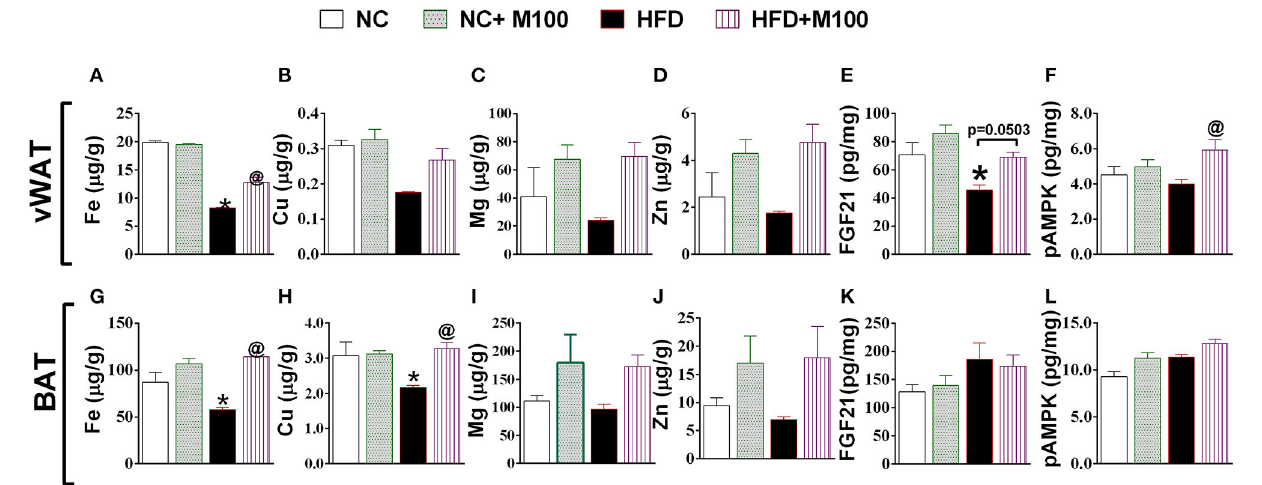
FIGURE 7 | Effect of chronic oral administration of menthol on (A–D) metal concentration (Fe, Cu, Mg, Zn) in vWAT; (E) FGF-21 in vWAT; (F) pAMPK in vWAT; (G–J) Metal concentration (Fe, Cu, Mg, Zn) in BAT; (K) FGF-21 in BAT; (L) pAMPK in BAT. NC, normal rodent chow fed; HFD, high fat diet fed; HFD + M100, HFD fed plus daily administration of 100 mg/kg menthol ( p.o. ); NC + M100, NC fed plus daily administration of 100 mg/kg menthol ( p.o. ); n = 3; All the values are expressed as mean ± S.E.M; Analysis was carried out by one-way ANOVA followed by Tukey’s multiple comparison; * p < 0.05 HFD and NC + M100 vs. NC; @ p < 0.05 HFD + M100 vs. HFD fed group.